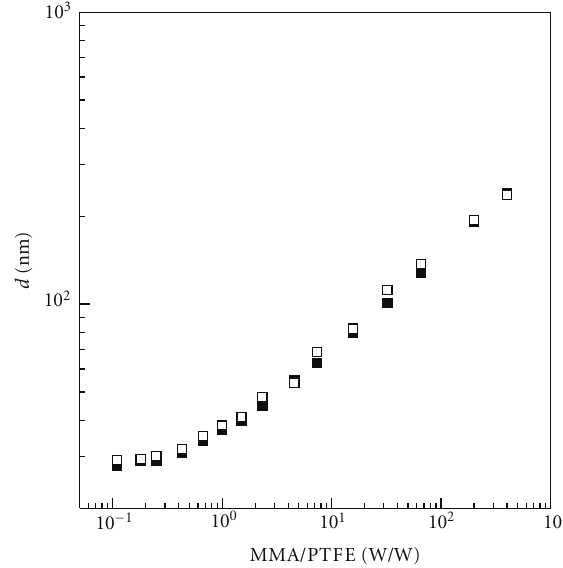
Figure 6: Trend of the particle diameter of the BPMn series as a function of the weight ratio between the initially added methyl methacrylate and PTFE. The full symbols refer to the calculated data, whereas the open symbols refer to the experimental